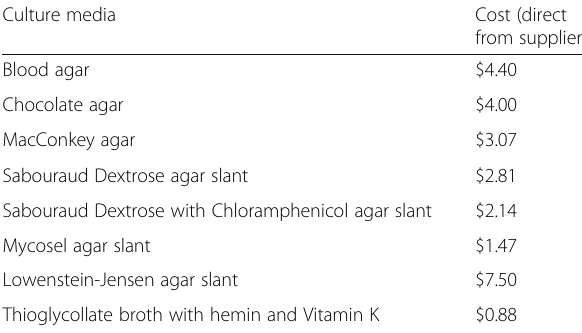
Table 1 Culture media used and cost of supplies